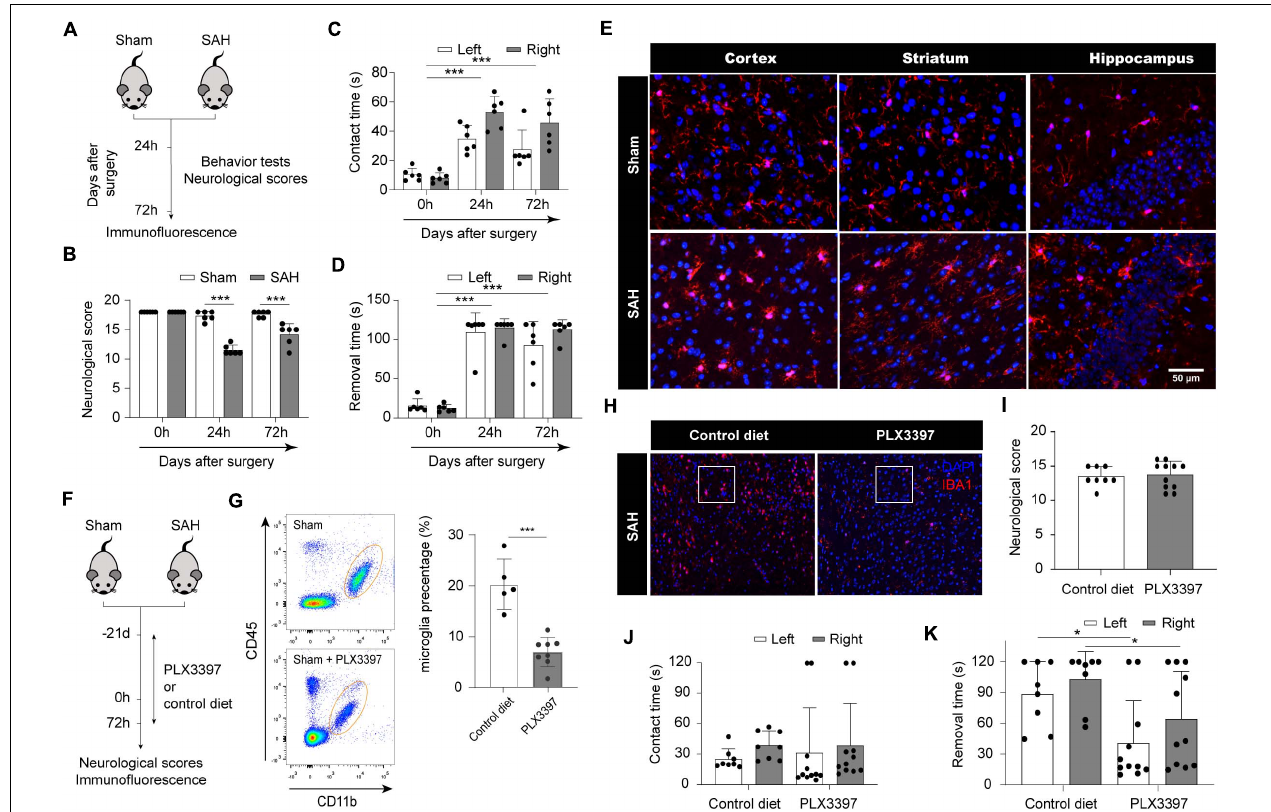
FIGURE 1 | Microglia lead to poor neurological outcome in acute stage after SAH. (A) Schematic diagram of experimental design. (B) Comparison of neurologic deficit scores among sham and SAH groups at 1 and 3 days after SAH. (C,D) Comparison of adhesive removal test results among sham and SAH groups at 1 and 3 days after SAH. (E) Immunofluorescence staining results of microglia in sham and SAH mice at 3 days after SAH, n = 3 per mice group. (F) Schematic diagram of microglia clearance. (G) Flow cytometry results proved that PLX3397 can clear microglia cells. (H) Immunofluorescence staining results of microglia in SAH mice fed with PLX3397 or control diet at 3 days after SAH. (I) Comparison of neurologic deficit scores among control diet and PLX3397 groups at 3 days after SAH. (J,K) Comparison of adhesive removal test results among control diet and PLX3397 groups at 3 days after SAH. SAH, subarachnoid hemorrhage; * P < 0.05, *** P <